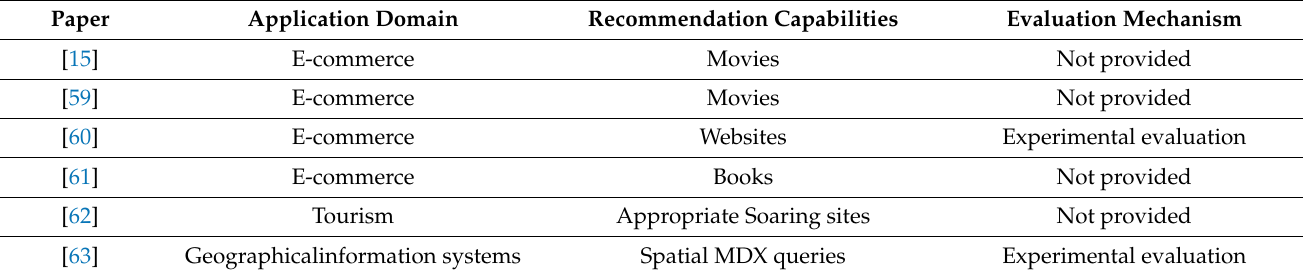
Table 3. Related work efforts of using data warehousing for generating